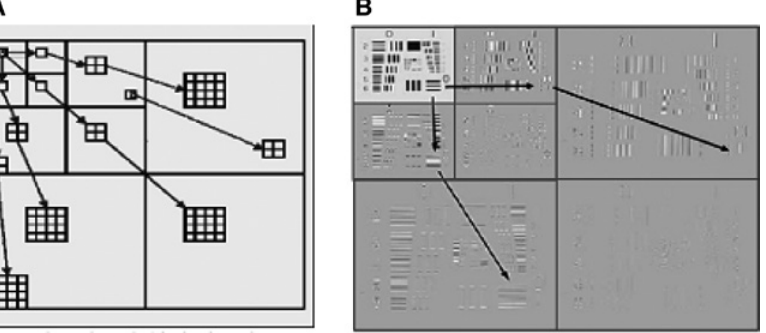
Figure 2: Roots of the Three Trees and Compression. (A) Representing well defined trees using wavelet and (B) represents prearranged